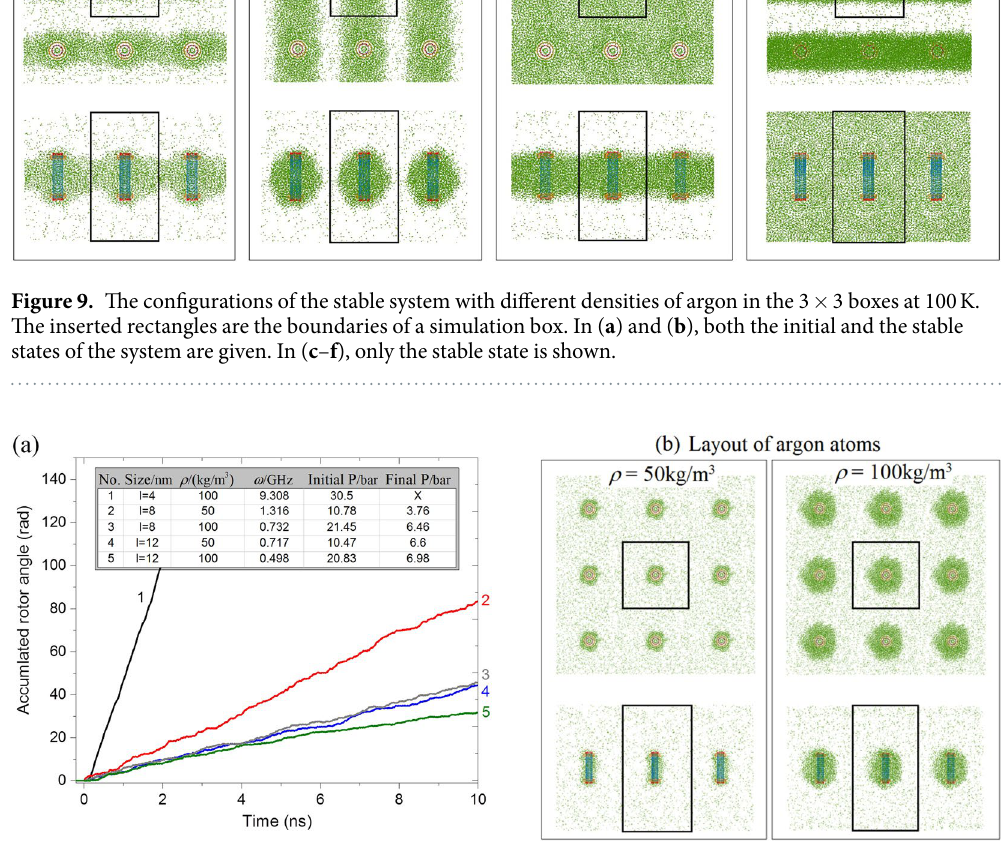
50 kg/m 3 , the value of ω of the rotor in the box with l = 8 is ~1.32 GHz, higher than that of the rotor in the box with l = 12. As evident from the differences among the final pressures of the boxes, the rotor attracts more argon atoms in the stable state of boxes with higher argon density. For example, in the same box with l = 12, the value of